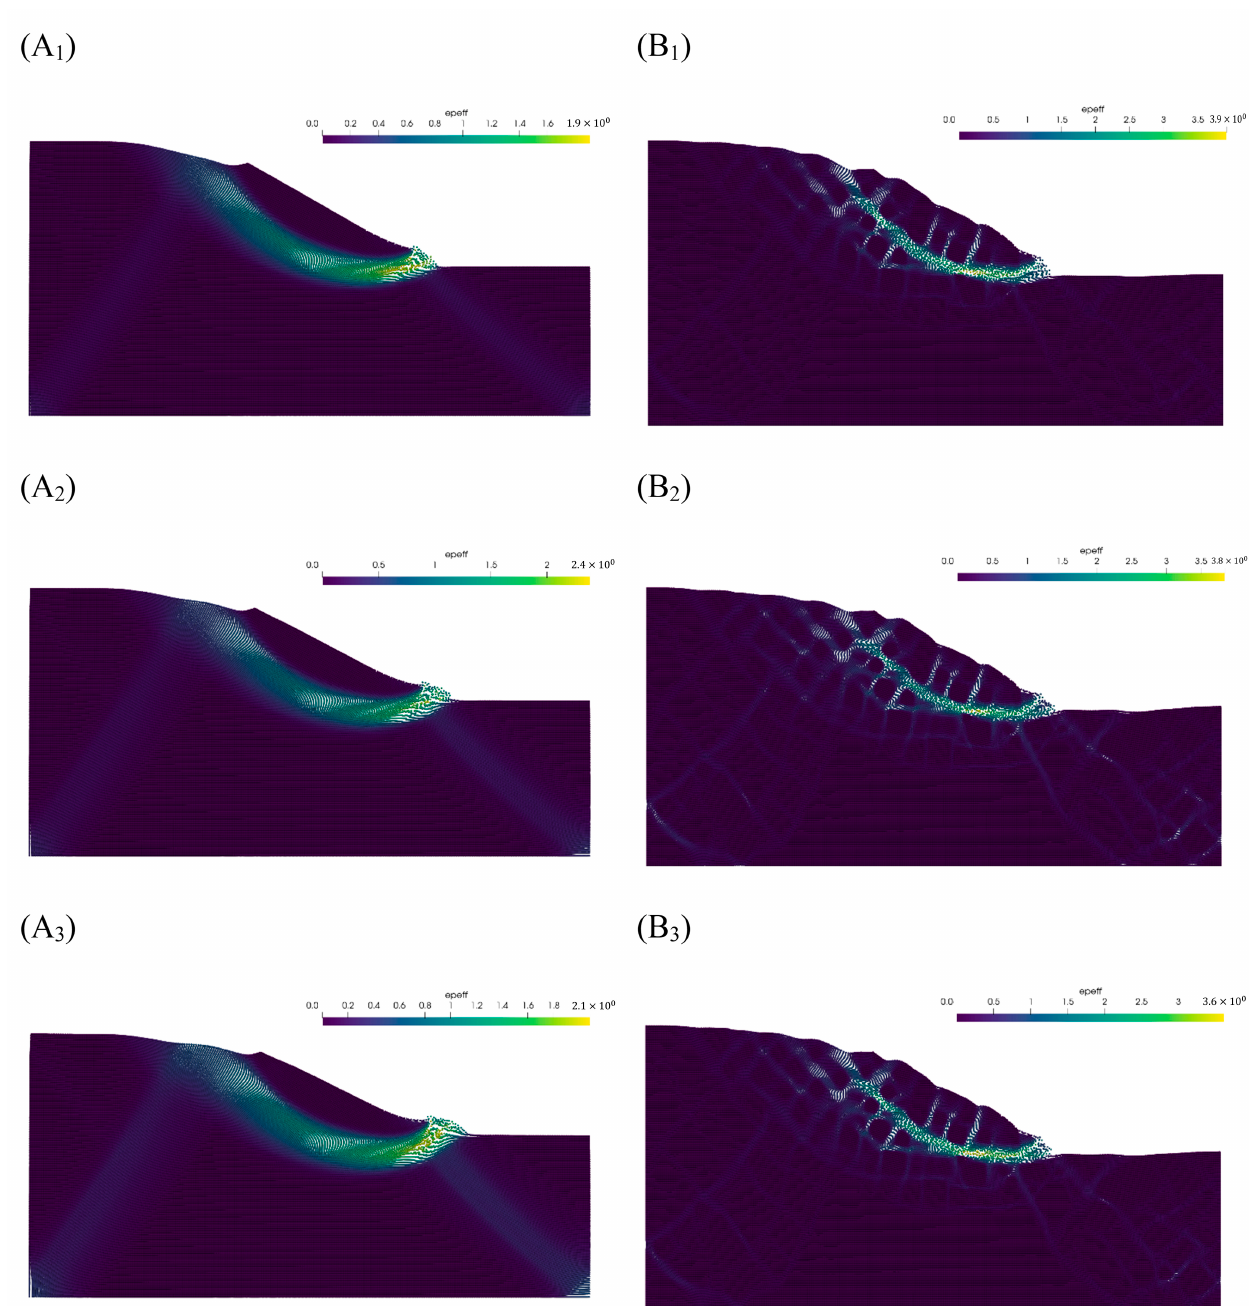
Figure 9. The plastic zone distribution cloud maps of the slopes at extreme conditions. ( A 1 – A 3 ) The plastic zone distribution of pure soil slopes at reduction factors equal to 1.8, 1.9, and 2.0, respectively. ( B 1 – B 3 ) The plastic zone distribution of SRM slopes at reduction factors equal to 2.3, 2.4, and 2.5, respectively.